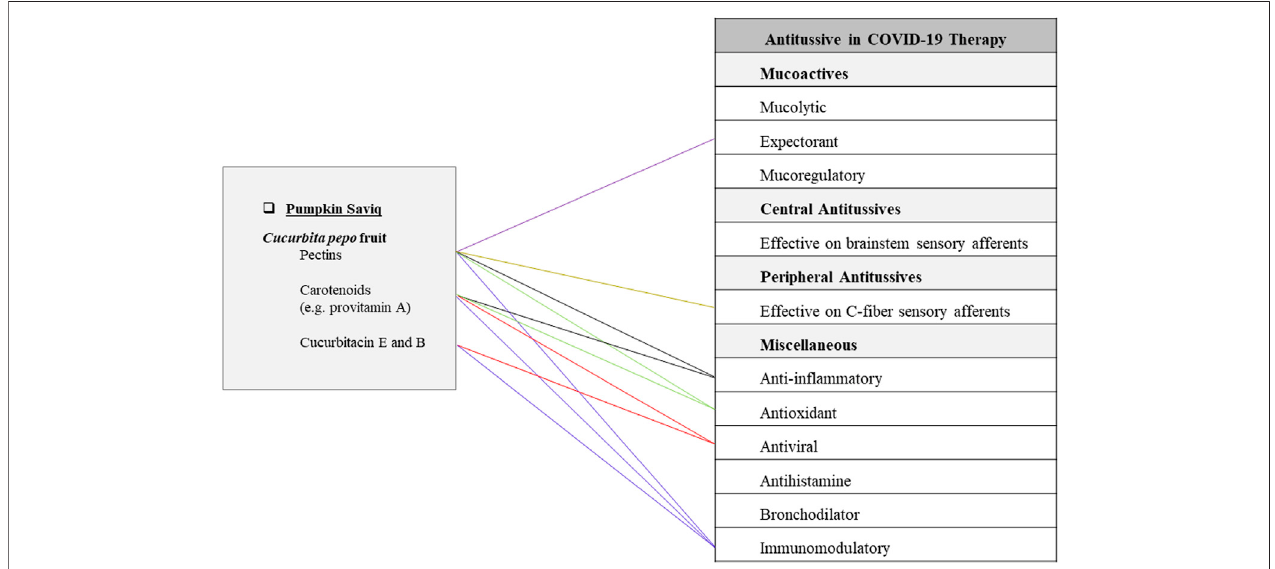
FIGURE 3 | Potentials of pumpkin Saviq as an antitussive Persian functional food in COVID-19 therapy.